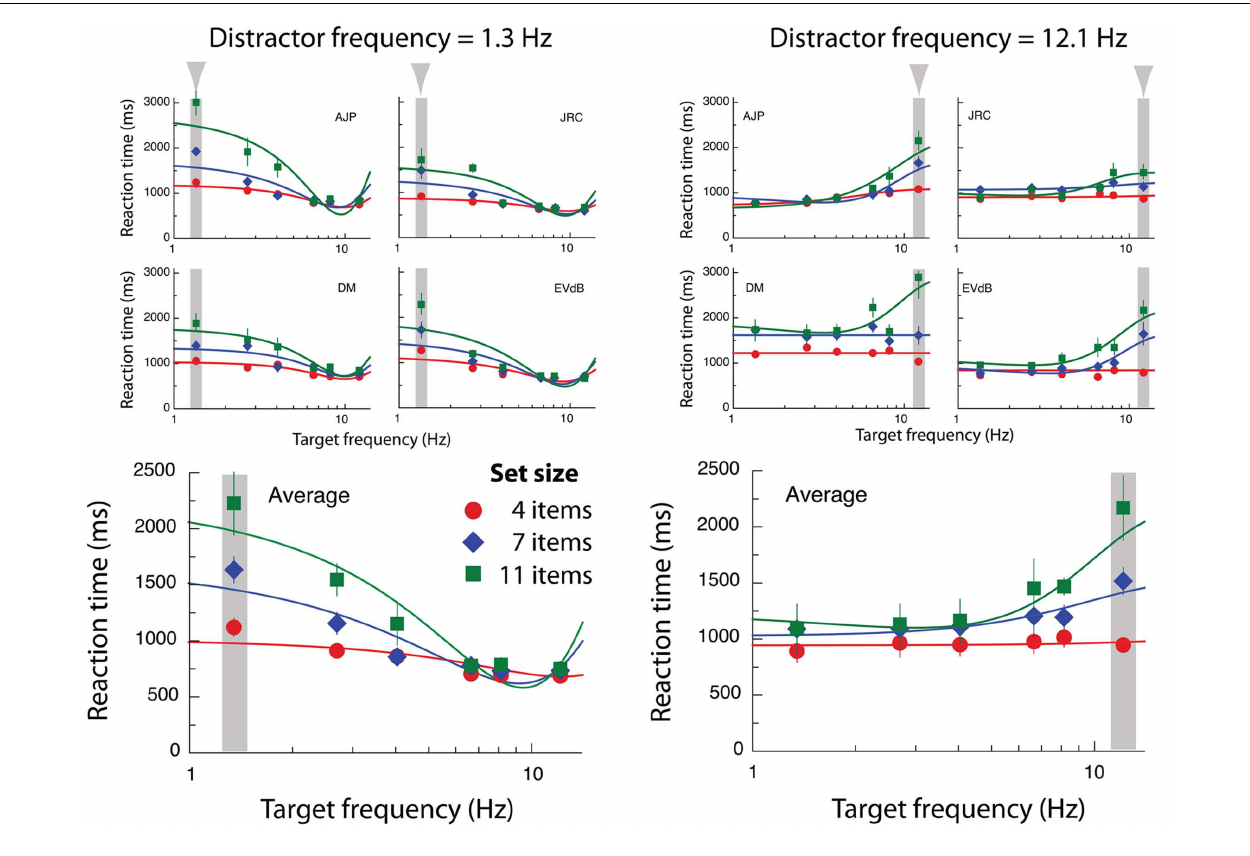
of all correct trials. Average data points represent between-subject means. Error bars for averaged data represent SE of individual means. Gaussian fits of averaged data were calculated independently of fits for individual